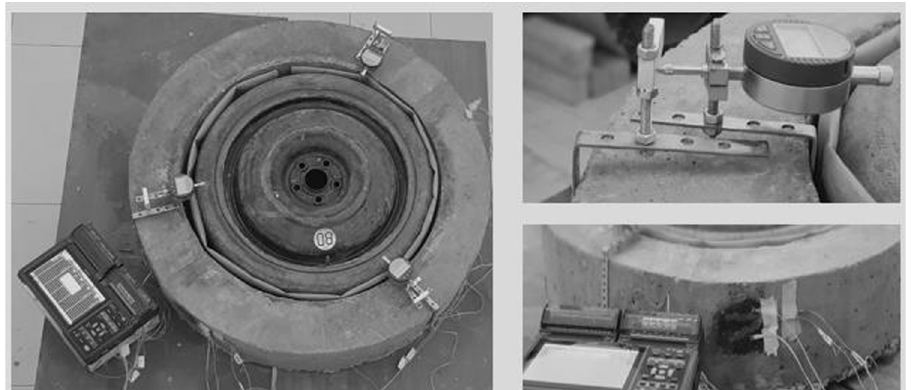
Figure 3: Description of experimental device and details of data acquisition